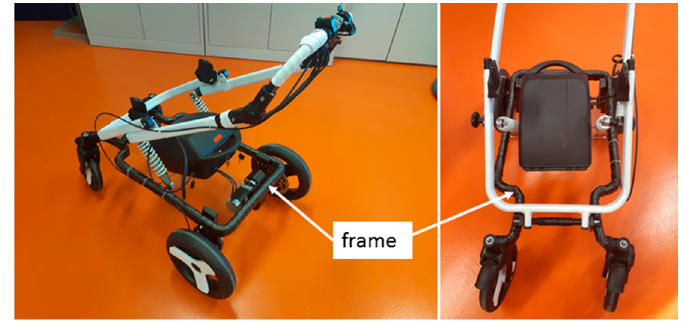
Figure 15. Test 1—Prototype of the baby carriage with supporting composite frame. Polymers 2020 , 12 , 1037